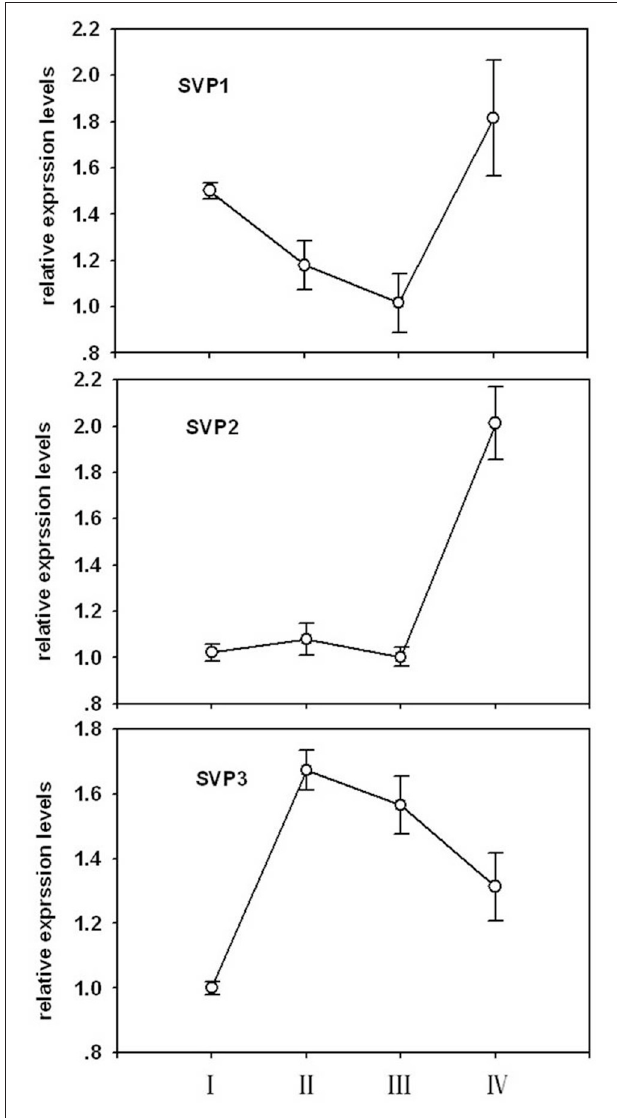
FIGURE 11 | The expression patterns of three LcSVPs in litchi buds. Vertical bars represent standard errors of means ( n = 3).